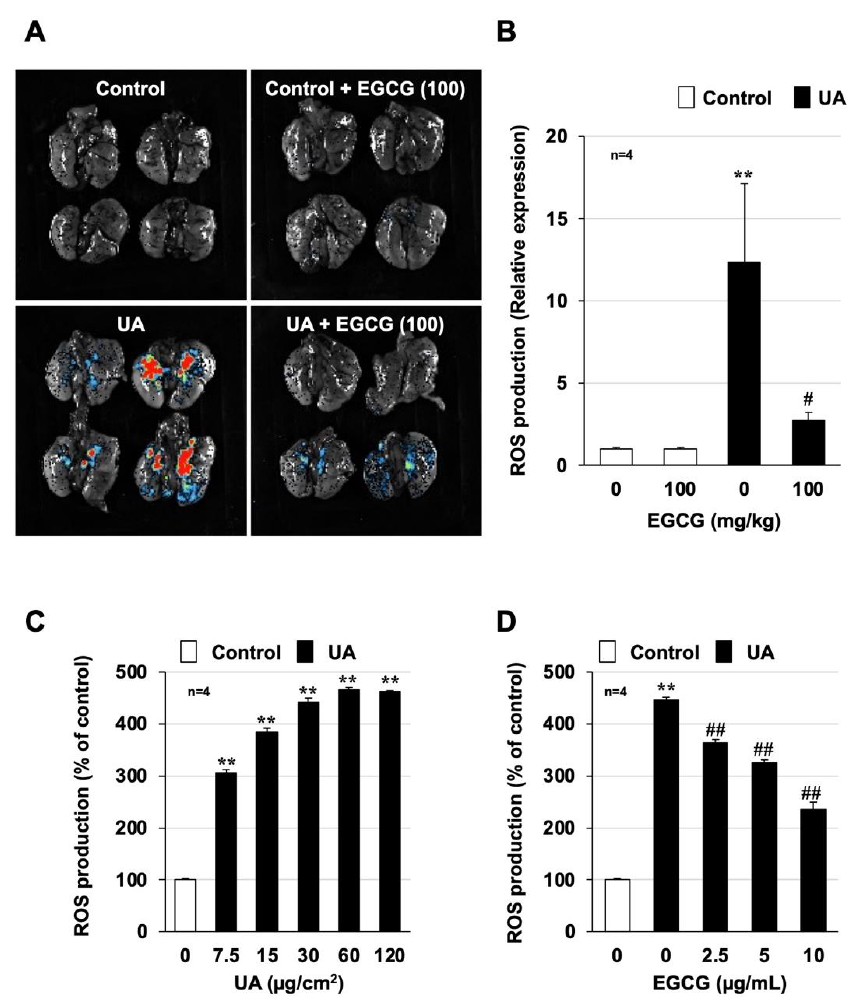
Figure 4. Effect of EGCG on urban aerosol-induced ROS production . ( A , B ) Male ICR mice were intraperitoneally administered EGCG (100 mg/kg in sterile saline) or sterile saline 1 h before intratra- cheal administration of urban aerosol particle suspension (1.0 mg/mouse) or sterile saline (Control). Luminescent probe (L-012, 75 mg/kg) was administered 24 h after administration of the urban aerosol particle suspension. ( A ) Isolated lungs were imaged using a FUSION chemiluminescence imaging system. ( B ) The summed pixel intensity of the ROS signal was determined using standard FUSION software. ( C , D ) RAW264 cells were treated with urban aerosols (7.5–120 µ g/cm 2 ) ( C ) or EGCG (2.5–10 µ g/mL) prior to the addition of urban aerosols (30 µ g/cm 2 ) ( D ) to the medium. The cells were precultured with H 2 DCFDA (10 µ M) for 60 min prior to EGCG and urban aerosol treatment. After 24 h, the ROS levels were measured using a microplate reader. Values represent the mean ± SEM; # p < 0.05; ** or ## p < 0.01. ( # vs.